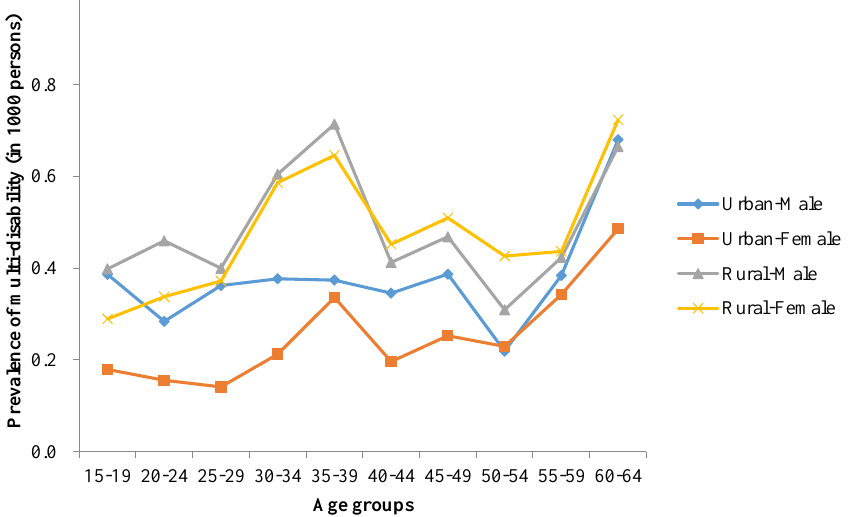
Figure 1. 1987 age standardized prevalence of multi-disability in the Chinese population aged 15–64.